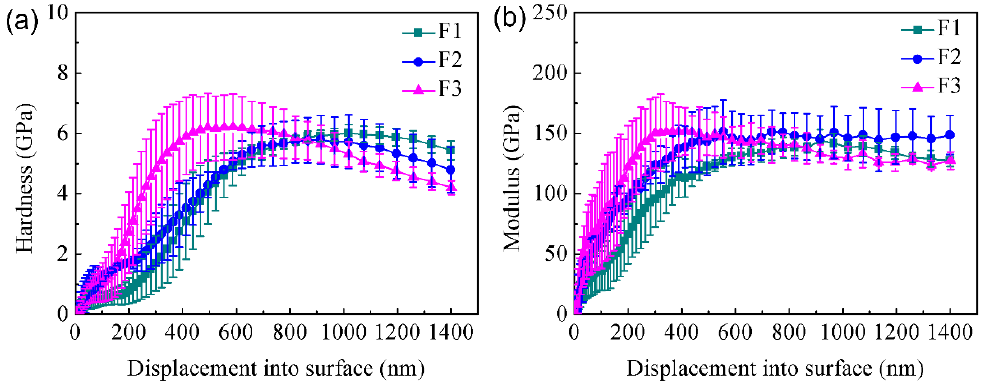
Figure 11. Surface hardness and modulus of the multiphase coating after plasma nitriding at 650 °C for 4 h, with increasing displacement: ( a ) hardness and ( b ) modulus.